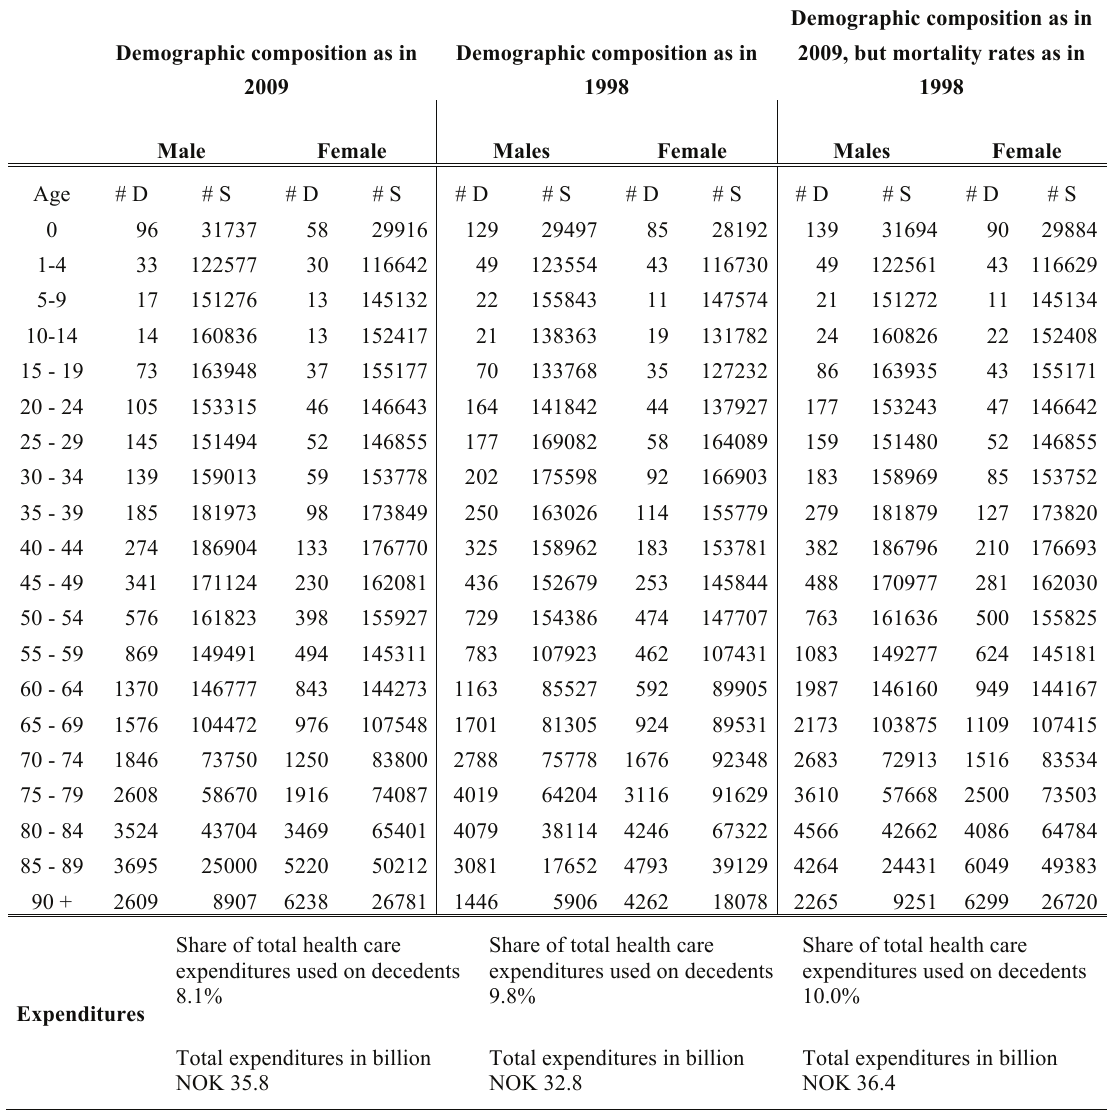
Table 5: The effect of increasing longevity on total hospital expenditures in Norway - Assuming the same per capita expenditures as in the regression presented in Table 3, but changed demographic composition